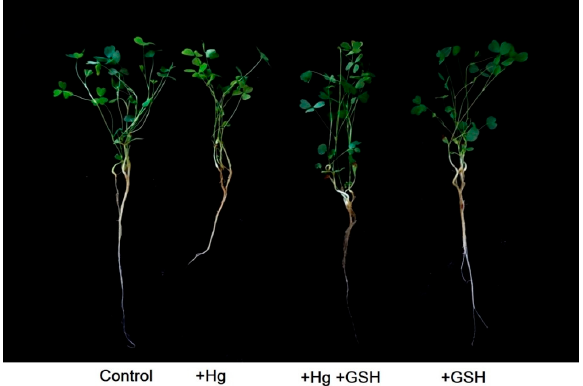
ff erent conditions of Hg and GSH: